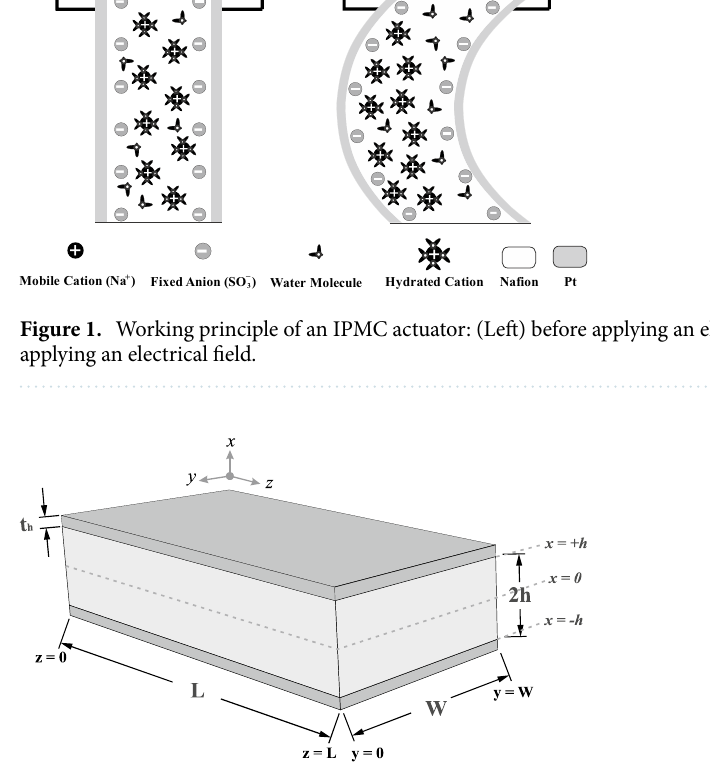
Figure 2. The geometric definition of an IPMC